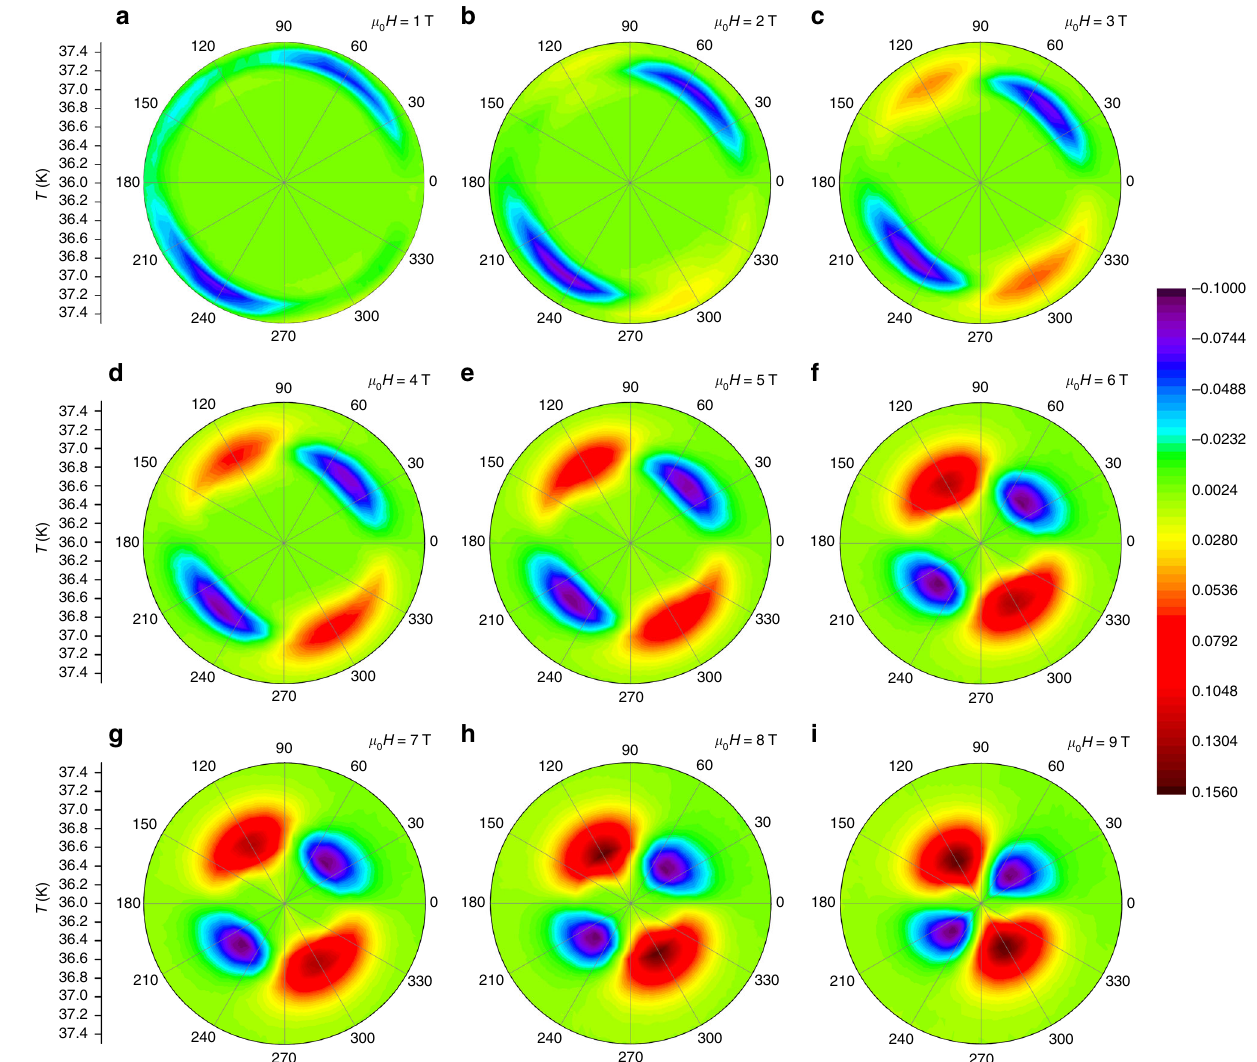
Fig. 3 Color contours of normalized magnetoresistivity. Angle-dependent normalized magnetoresistivity ( ρ − ρ 0 )/ ρ n at various temperatures and magnetic fi elds. The color bar represents the normalized magnetoresistivity ( ρ − ρ temperature of 39